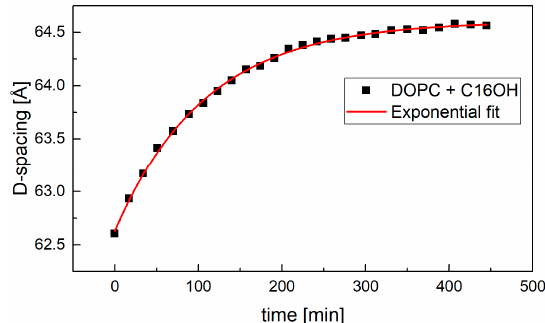
Figure 6. The kinetics of sample hydration in excess water condition. The sample’s full hydration was achieved typically in about 350 min.